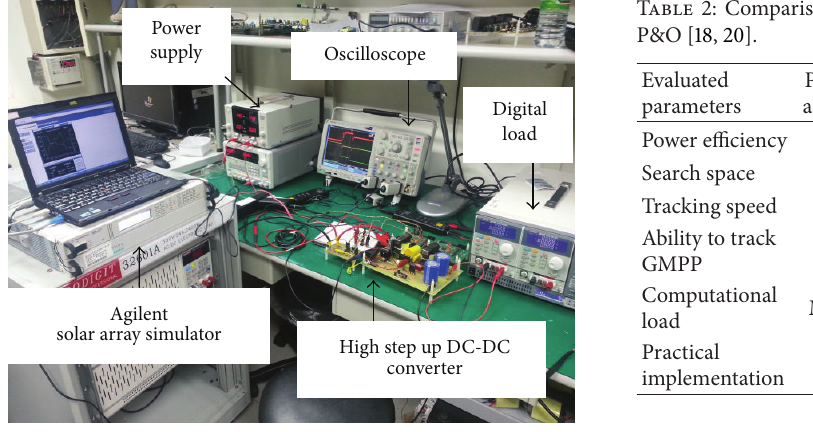
Figure 8: Experimental setup for the proposed PV system.